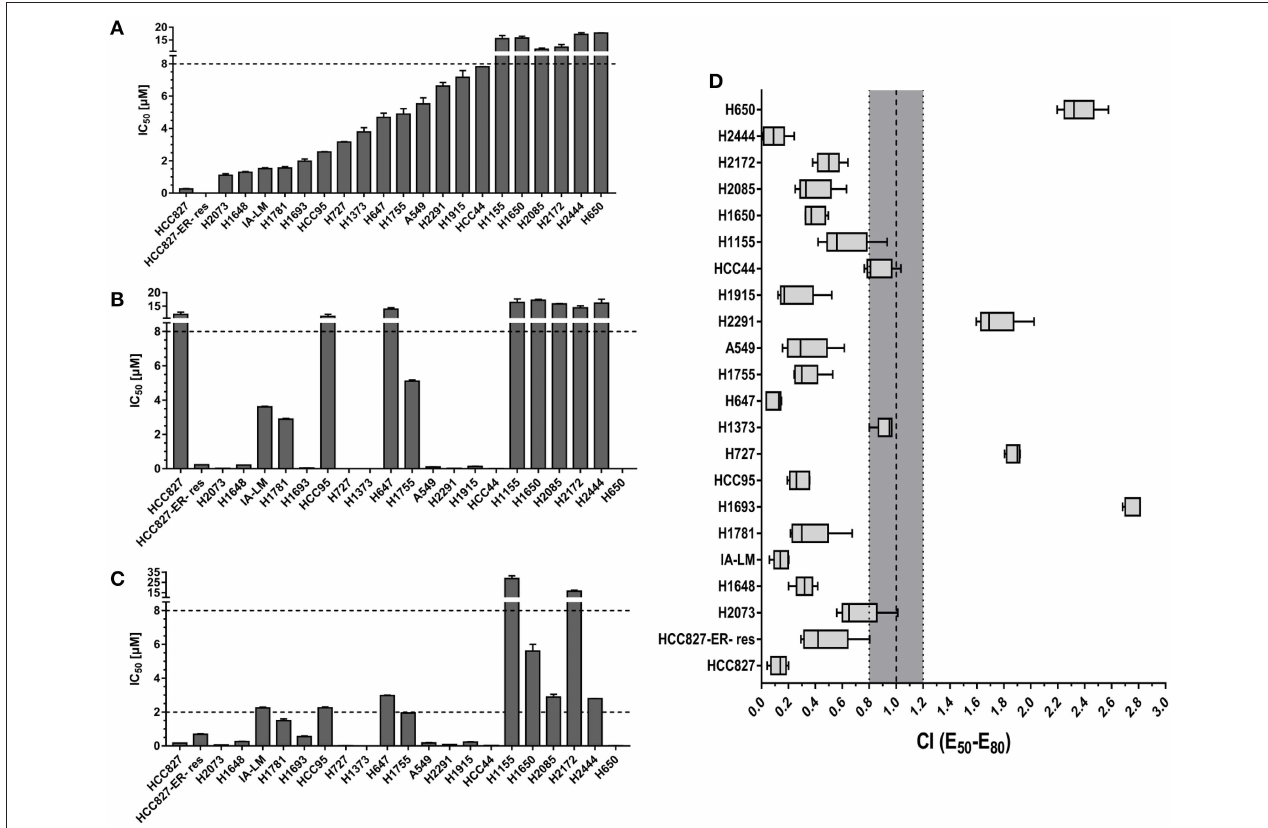
FIGURE 1 | The combination of MEK inhibitor trametinib with SRC inhibitor bosutinib promoted synergistic inhibition of cell growth in NSCLC cell lines. Cell proliferation IC 50 plots (mean ± SD) for a panel of 22 NSCLC cell lines treated with bosutinib (A) , trametinib (B) , or the combination of bosutinib and trametinib (C) for 24h. Data were tabulated from three independent experiment sets. (D) Combination index (CI) box plots of bosutinib and trametinib co-treatment at a ratio of 1:1 on the cell line panel. Combination index of CI < 0.8 indicates synergism, CI from 0.8 to 1.2 indicates additive effect, and CI > 1.2 indicates antagonism.